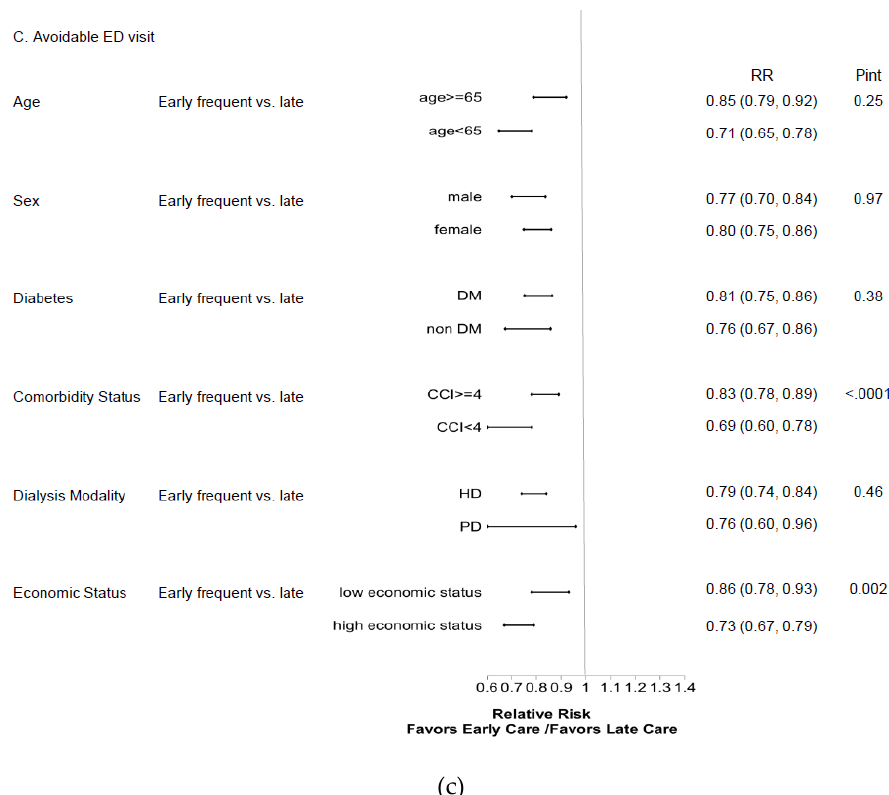
Figure 3. Subgroup analysis of relative risk for 1-year ED visits between the early-frequent and late-nephrology-care groups for recurrent events of ( a ) all-cause, ( b ) infection-related, and ( c ) potentially avoidable ED visits. Abbreviations: ED, emergency department; CCI, Deyo’s Charlson Comorbidity Index; DM, diabetes mellitus; HD, hemodialysis; HR, hazard ratio; PD, peritoneal dialysis; Pint, p value for interaction term.